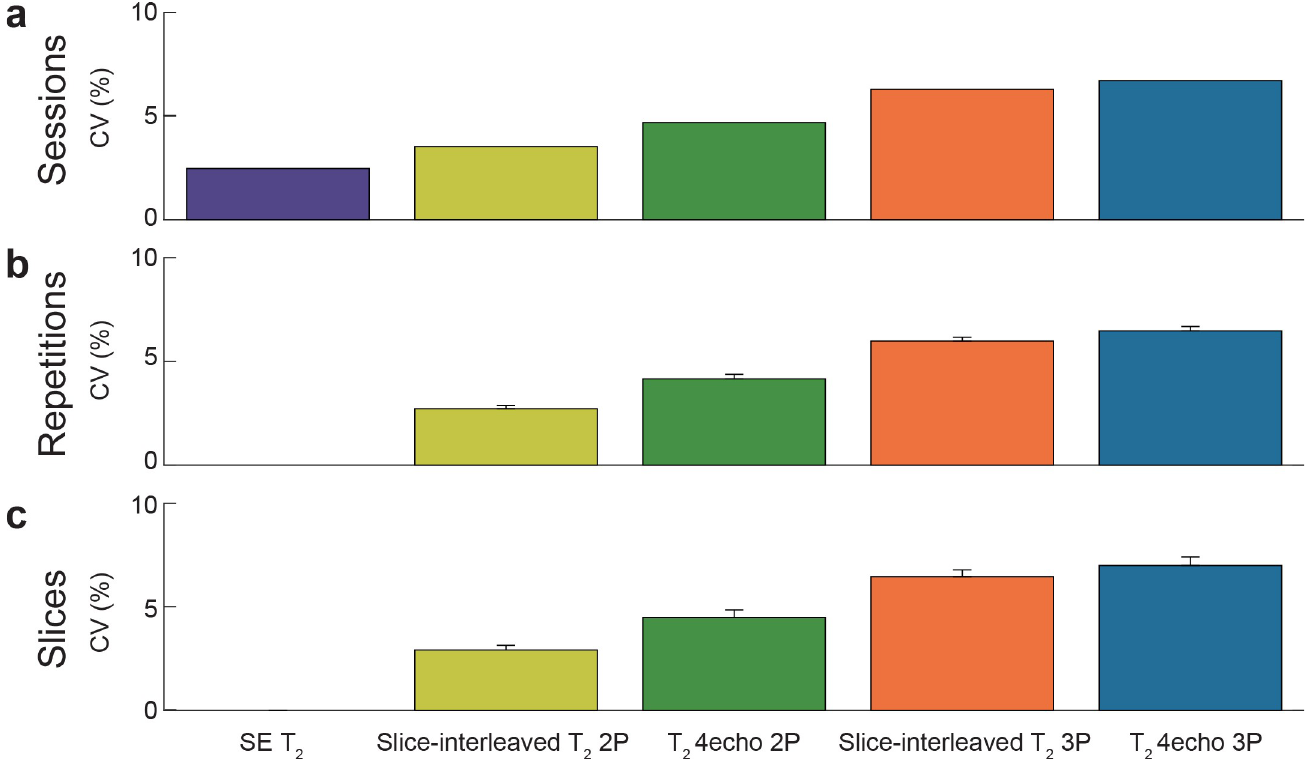
Fig 5. Reproducibility between sessions, and repeatability between repetitions and slices of slice-interleaved T 2 mapping sequences were estimated using coefficients of variation (CV). Slice-interleaved T 2 mapping had good between-session reproducibility (CV: SE T 2 = 2.5%, slice-interleaved T 2 2P = 3.5%, slice- interleaved T 2 3P = 6.3%, slice-interleaved T 2 4-T 2 preps 2P = 4.7%, slice-interleaved T 2 4-T 2 preps 3P = 6.7%), between-repetition repeatability (CV: slice- interleaved T 2 2P = 2.7 ± 0.2%, slice-interleaved T 2 3P was 6.0 ± 0.2%, slice-interleaved T 2 T 2 preps 2P = 4.2 ± 0.2%, slice-interleaved T 2 T 2 preps 3P was 6.5 ± 0.2%), and good between-slice repeatability (CV: slice-interleaved T 2 2P = 2.9 ± 0.2%, slice-interleaved T 2 3P = 6.5 ± 0.3%, slice-interleaved T 2 T 2 preps 2P = 4.5 ± 0.4%, slice- interleaved T 2 T 2 preps 3P was 7.0 ±